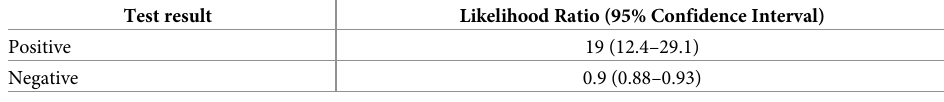
Table 3. The likelihood ratios (LRs) of thermal screening as a diagnostic test at POC.